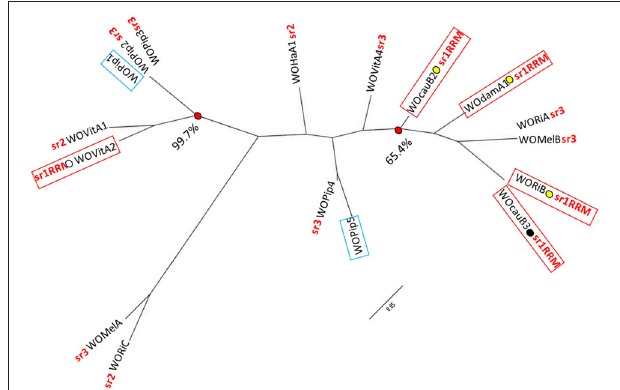
FIGURE 3 | Representative maximum likelihood tree constructed from a 1031 nucleotide position alignment of 17 WO minor capsid protein gene sequence. The tree (historically used for WO classification) includes sequences from all the WOs used in Figure 1 , as well as two additional WO sequences (from WOPip1 and WOPip5), the genomes of which lack integrase/recombinase genes ( Kent et al., 2011a). The gene sequences of WOPip1 and WOPip5 are highlighted with blue boxing. Minor capsid gene sequences originating from WOs with the group 1 serine replication recombinase module (sr1RRM) referred to in the main text are indicated, as are their integration sites (labeled as in Figure 1 ). The serine recombinase-based phylogenetic classification of these WOs is also highlighted, using branch tip suffixes written in red (sr1–sr3). The bootstrap support for two monophyletic groups containing WO sequence representatives with varying integrase/recombinase gene sequences is also shown. The minor capsid protein sequences alignment is provided in Supplementary File